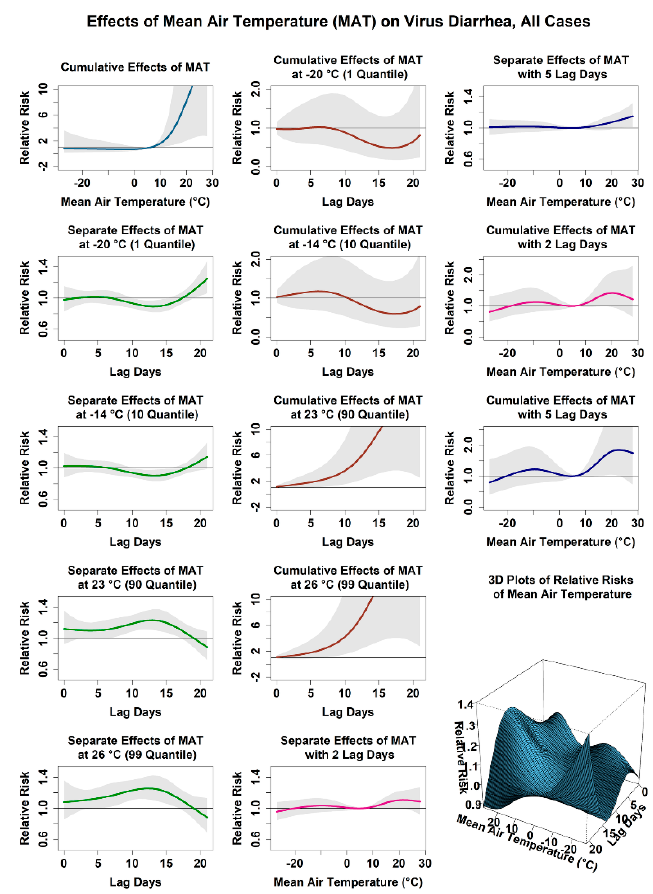
Figure 2. Effect of mean air temperature on virus diarrhea in Jilin Province, all cases.